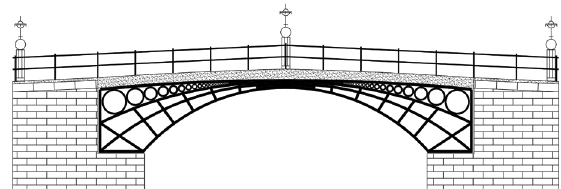
Fig. 1. A view of the first iron bridge in the European continent at Łażany (Laasan)